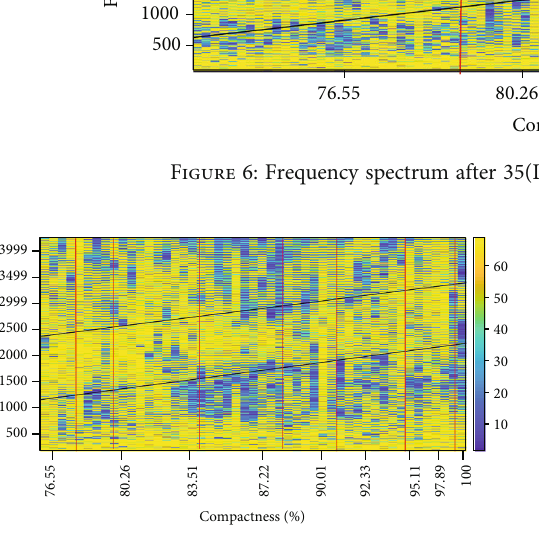
Figure 7: Frequency spectrum after 45(L) N hammering force is reduced by one-sixth.